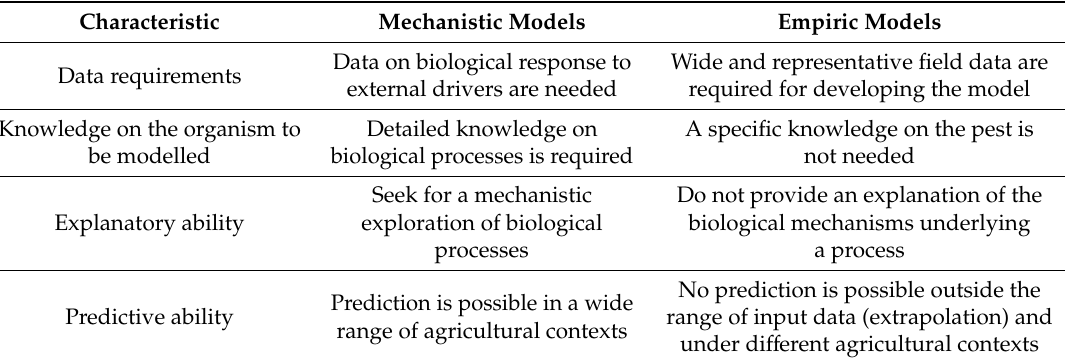
Table 1. Main characteristics of empiric and mechanistic